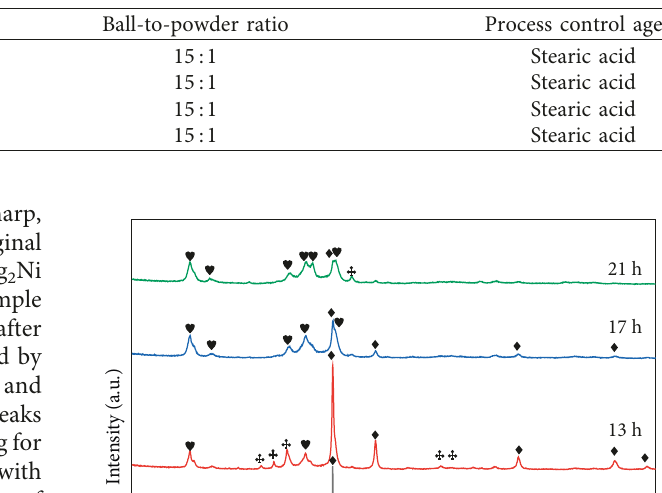
Table 2: Milling process parameters of HCX-2.